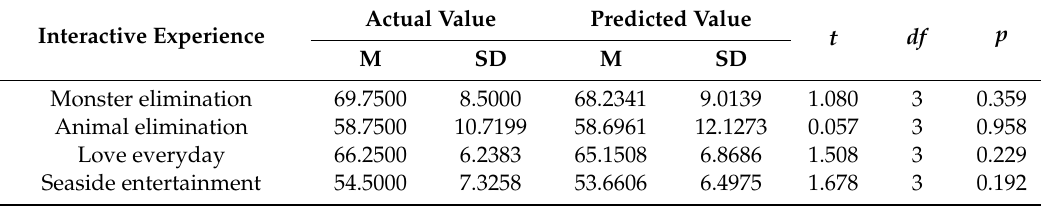
Table 4. The test results of the actual value and predicted value in the free browsing stage. Actual Value Interactive Experience